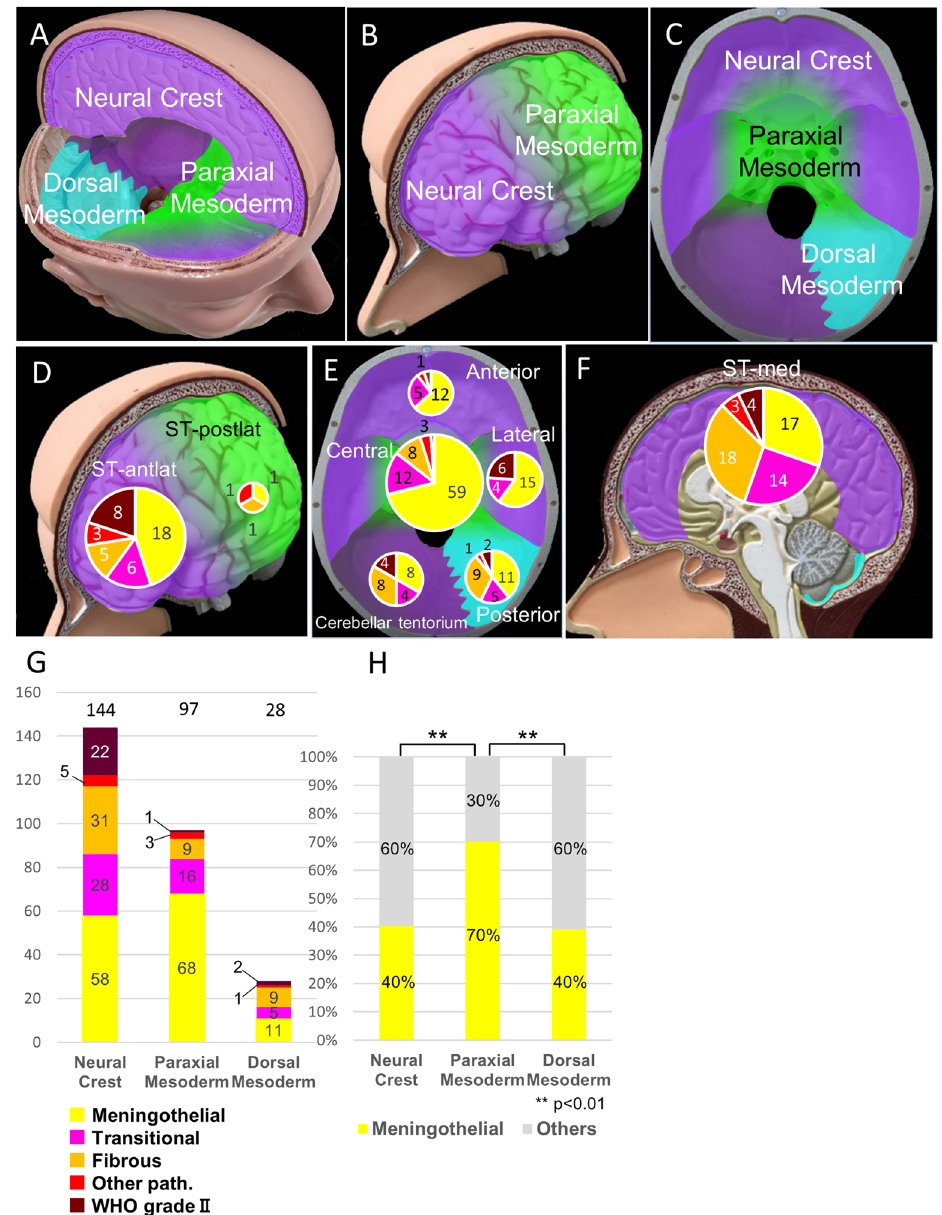
Figure 1. Pathological diagnosis according to embryologically classified anatomical location of meningiomas. ( A – C ) Embryological origins of the intracranial meninges. ( D ) Pathological distribution at ST-ant/lat and ST-post/lat. Each pie chart provides a breakdown of the number of each pathological diagnosis. The size of the pie charts reflects the total number of cases of this type of lesion. ( E ) Pathological distribution at the skull- base. The numbers indicate the number of cases for each location. The sizes of the pie chart indicate the total number of cases for each location. ( F ) Pathological distribution at ST-med. The number indicates the number of cases for each location. The sizes of the pie chart indicate the total number of cases for each location. ( G ) The number of pathological diagnoses for each embryologically classified tumor. The bar graph shows the number of pathological diagnoses for each embryologically classified tumor. ( H ) Comparison of the ratio of meningothelial meningioma among embryologically classified tumors. The ratio of meningothelial meningioma is significantly higher in tumors derived from the paraxial mesoderm rather than the neural crest or dorsal mesoderm. ( p < 0.01, statistically significant on the chi-square test with Bonferroni correction). ST-ant/lat, supra-tentorial- antero-lateral; ST-post/lat, supra-tentorial-postero-lateral; ST-med, supra-tentorial-medial. Figure generated using Microsoft PowerPoint 2016, https:// www. micro soft.